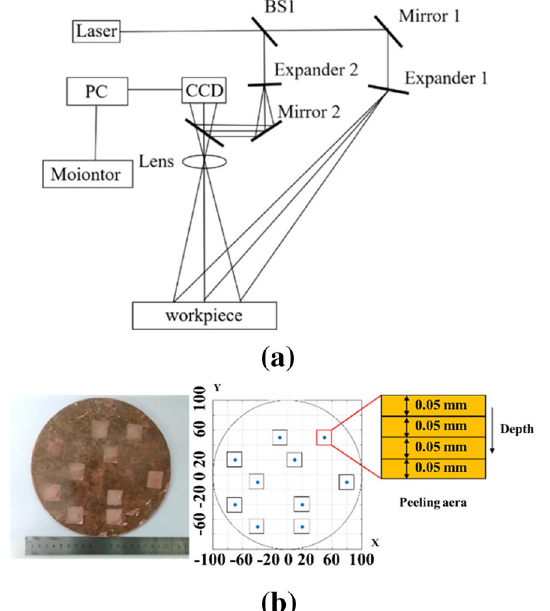
Figure 2 ( a ) Measuring principle of PRISM [22] and ( b )